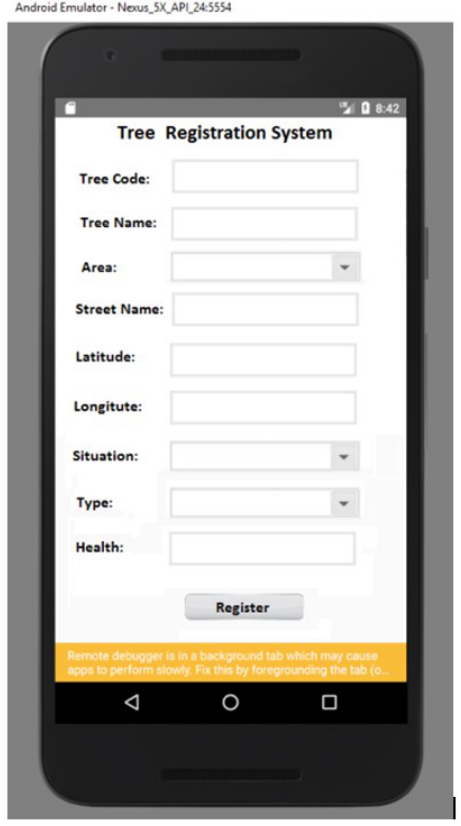
Figure 4. Android Application Interface for Tree Inventory